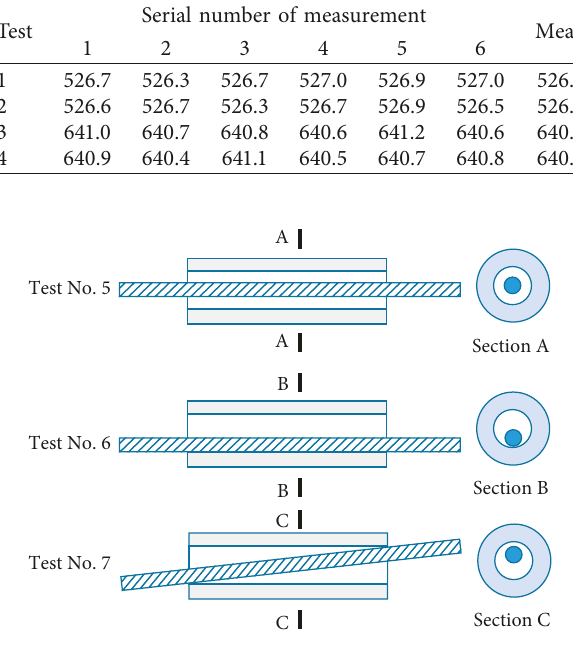
Figure 5: Positions of tendon in the sensor. Table 2: Integral voltages of specimen with various